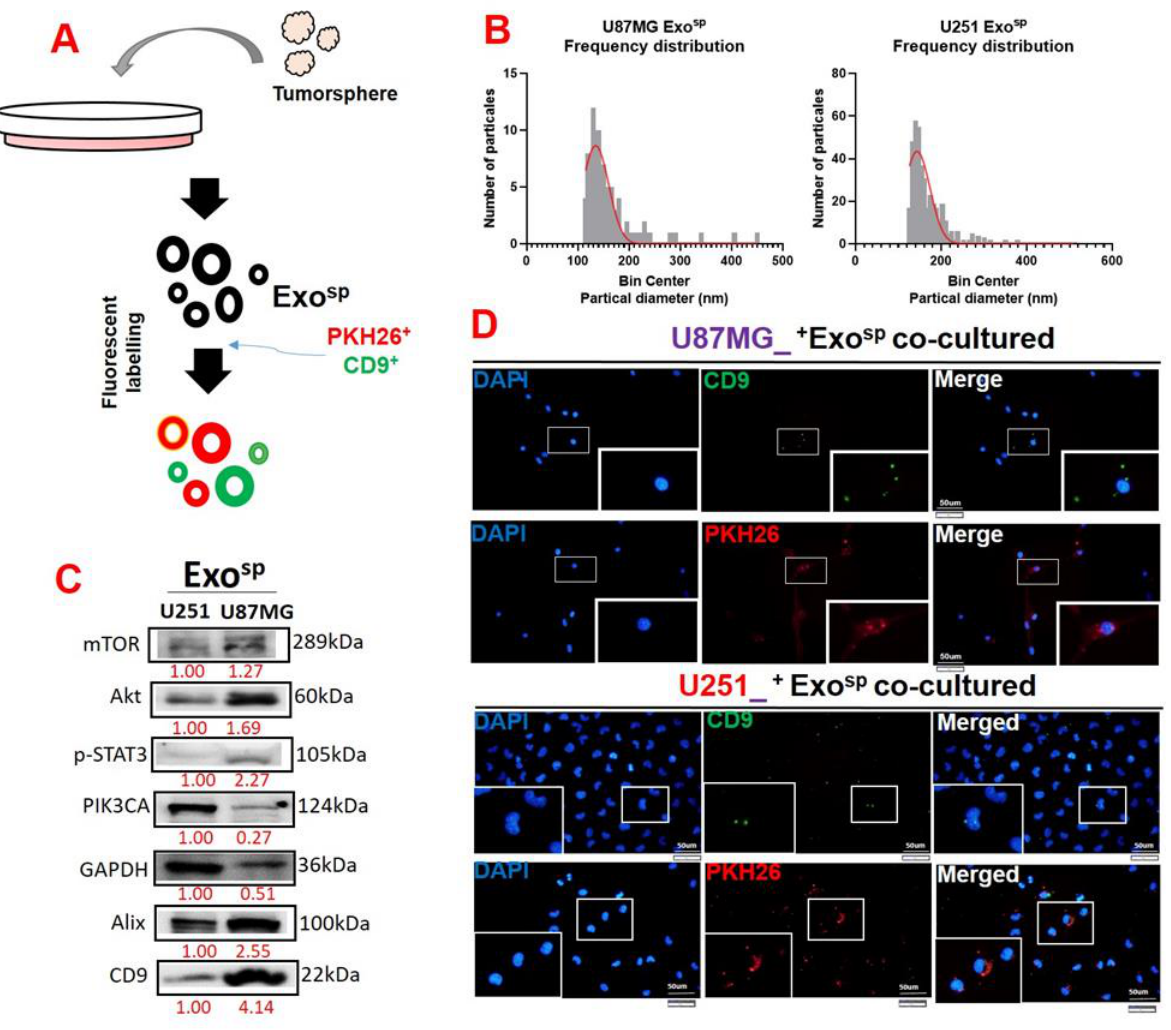
Figure 5. Characterization of tumorsphere-derived exosomes (Exo sp ). ( A ) Schematic representation of exosome isolation from the U87MG and U251 tumorsphere. ( B ) Particle analysis demonstrated that exosomes (Exo sp ) isolated from U87MG and U251 tumorspheres were in the 130 and 170 nm diameter range. ( C ) Western blots of isolated Exo sp from U87MG and U251 cells indicated the exosomal cargo of p-STAT3, Akt, mTOR, and PIK3CA. ( D ) Immunofluorescence imaging depicting the uptake of Exo sp in the recipient cells; CD9 (green fluorescence) and PKH26 (red fluorescence) were both exosomal trackers. Numbers in red indicate the relative expression ratio. ** p < 0.01, *** p < 0.001.